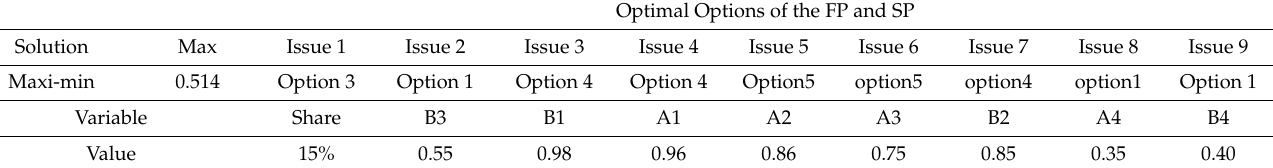
Table 10. 5.4. Summary of the Effect of the Three Contracts on the Economic Evaluation Model of the AA oil